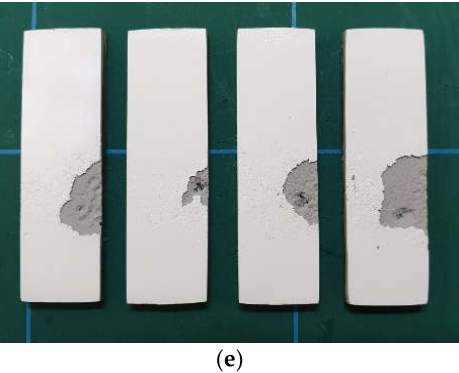
Figure 6. ( a ) Samples with coating A at stage 1; ( b ) samples with coating A at stage 2; ( c ) samples with coating A at stage 3; ( d ) samples with coating A at stage 4; ( e ) samples with coating A at stage 5. Figure 7 presents images of five individual specimens with coating B after each erosion stage.